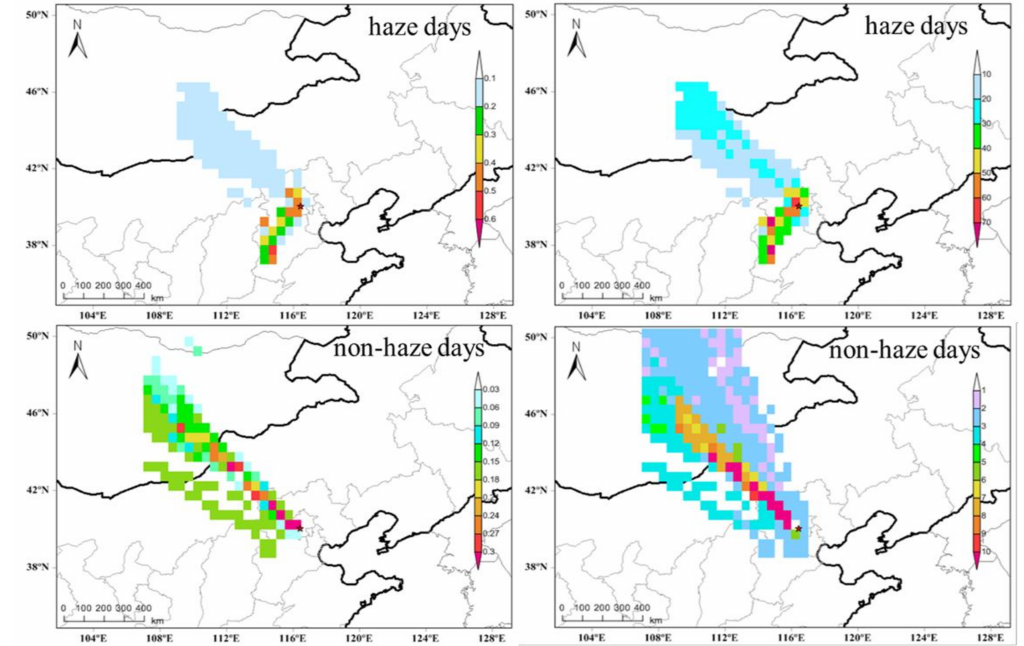
Figure 7. The potential source contribution function (PSCF) ( left ) and concentration weighted trajectory (CWT) ( right ) from CRAES during haze days and non-haze